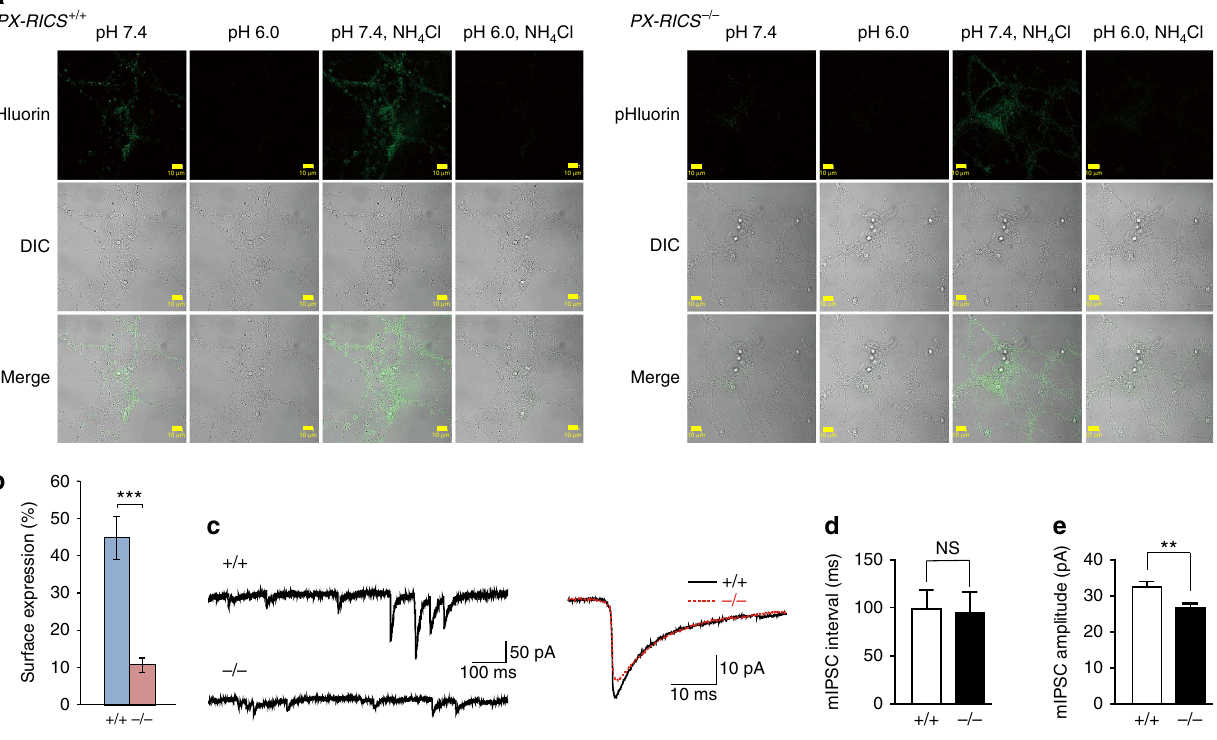
Figure 3 | Decreased surface GABA A R expression and GABA-mediated inhibitory synaptic transmission in PX-RICS (cid:2) / (cid:2) neurons. ( a ) Sequential fluorescent (pHluorin) and differential interference contrast (DIC) images of PX-RICS þ / þ (left) and PX-RICS (cid:2) / (cid:2) (right) live cortical neurons expressing g 2 EP . The settings of the microscope, lasers and detectors were kept unchanged during image acquisition. Scale bars, 10 m m. ( b ) Decreased surface expression of g 2 in PX-RICS (cid:2) / (cid:2) neurons. Surface expression was calculated as follows: surface expression (%) ¼ 100 (cid:3) ( I 7.4 (cid:2) I 6.0 )/( I 7.4N (cid:2) I 6.0N ), where I 7.4 , I 6.0 , I 7.4N and I 6.0N represent the fluorescent intensities in the imaging buffer at pH 7.4, pH 6.0, pH 7.4 containing NH 4 Cl and pH 6.0 containing NH 4 Cl, respectively. n ¼ 20 ( PX-RICS þ / þ ) and 20 ( PX-RICS (cid:2) / (cid:2) ) fields. ( c ) Representative traces of mIPSCs (left) and averaged traces of mIPSCs (right) in hippocampal CA1 pyramidal cells from PX-RICS þ / þ and PX-RICS (cid:2) / (cid:2) mice. In total, 221 and 330 consecutive events with no overlap with other events were averaged for PX-RICS þ / þ and PX-RICS (cid:2) / (cid:2) neurons, respectively. ( d , e ) The median intervals ( d ) and amplitudes ( e ) of mIPSCs in PX-RICS þ / þ and PX-RICS (cid:2) / (cid:2) neurons. n ¼ 18 ( PX-RICS þ / þ ) and 20 ( PX-RICS (cid:2) / (cid:2) ) cells ( c – e ). Data are represented as means ± s.e.m. NS, not significant; ** P o 0.01; *** P o 0.001 (unpaired two-tailed Student’s t